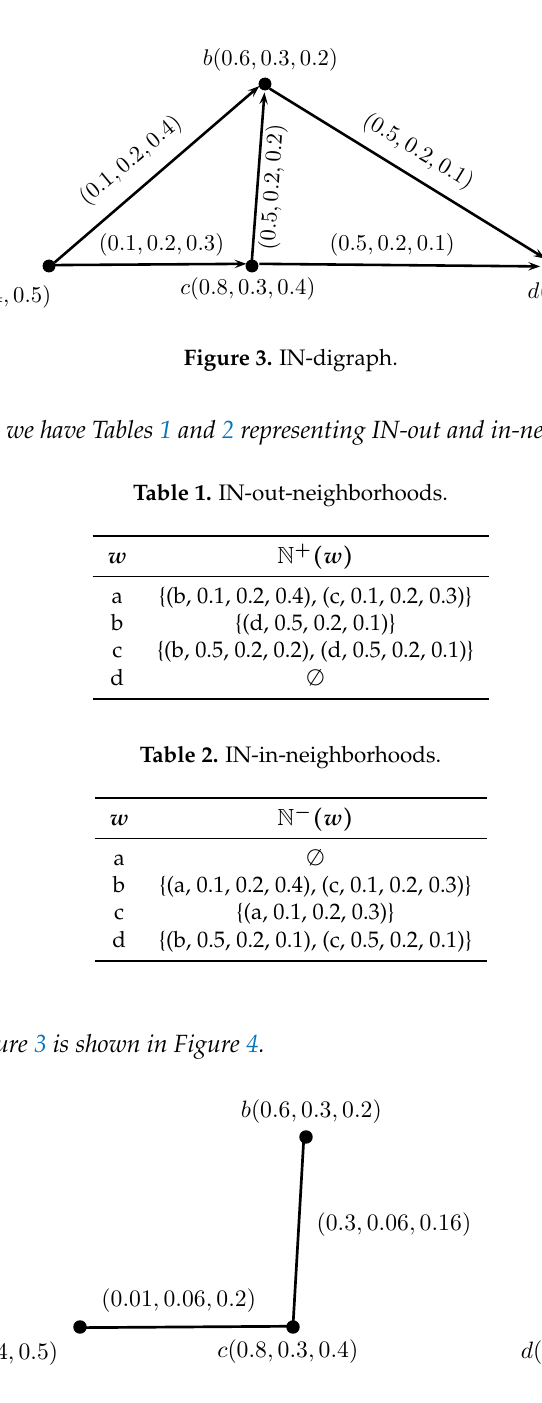
Figure 4. Intuitionistic neutrosophic competition graph